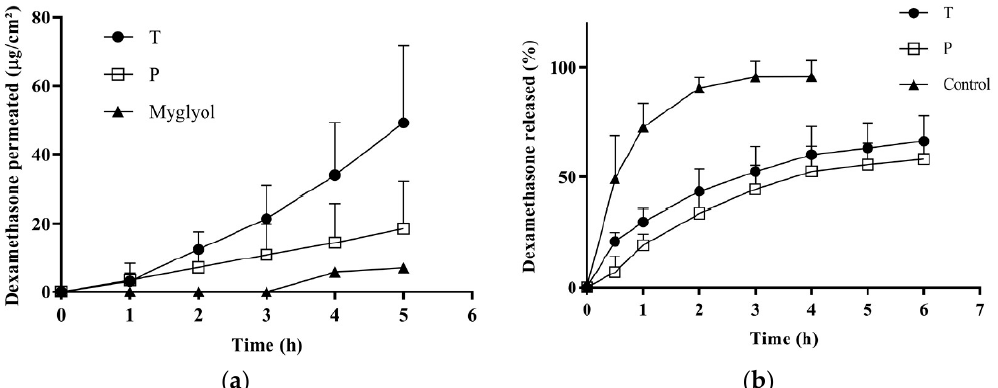
Figure 4. ( a ) Transconjunctival permeation profiles of dexamethasone from formulations T, P and from Miglyol ® dispersion; ( b ) dexamethasone release from T and P micelles and from a solution (EtOH:PBS 1:1).